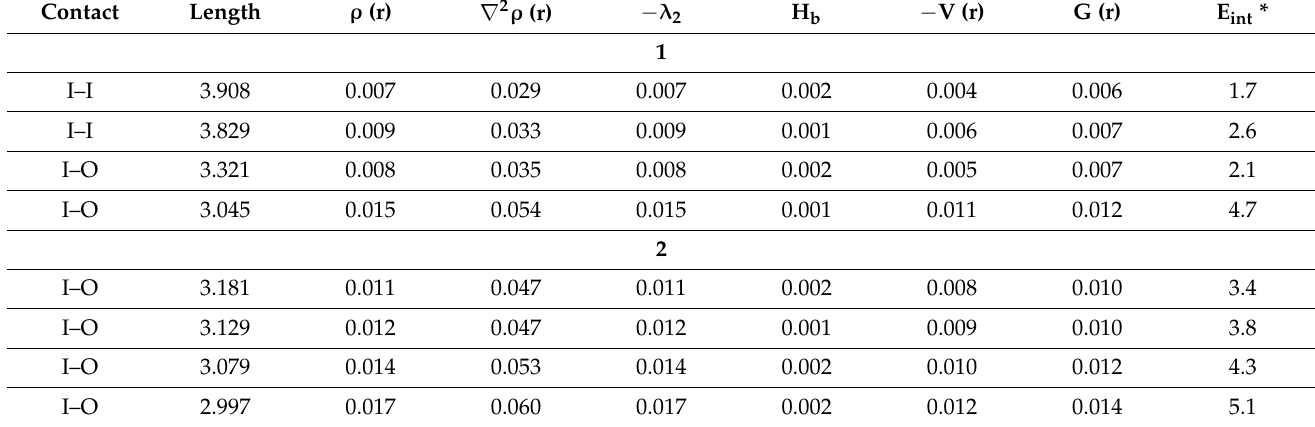
Table 2. Values of the density of all electrons ρ ( r ), Laplacian of electron density ∇ 2 ρ ( r ) and appropriate λ 2 eigenvalues; energy density H b , potential energy density V( r ), and Lagrangian kinetic energy G( r ); and electron localization function ELF (a.u.) at the bond’s critical points (3, –1) for intermolecular interactions in 1 and 2 , and their estimated strength E int